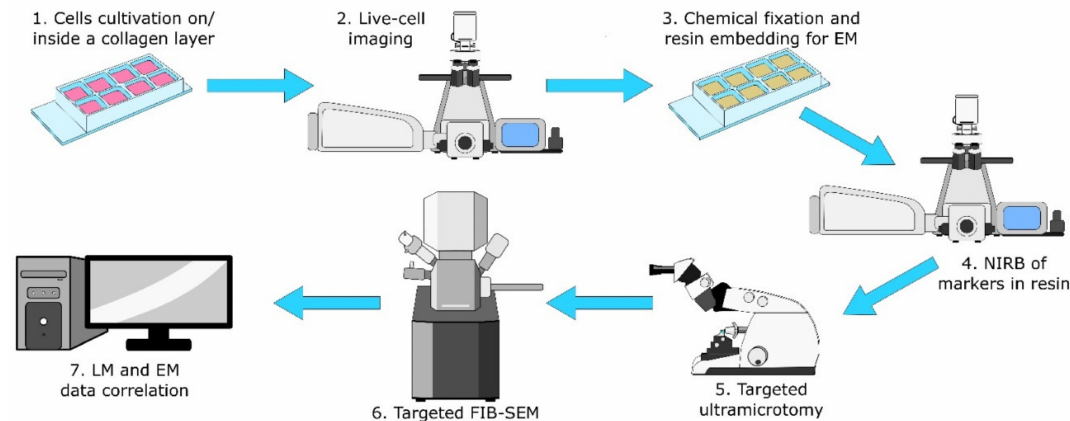
Figure 1. Scheme of the protocol. ( 1 ) Cells cultivation on/inside a collagen layer in eight-well chambers. ( 2 ) Live-cell confocal imaging of the target cell. ( 3 ) Chemical fixation and resin embedding for EM. ( 4 ) In-resin NIRB of fiducial markers for XY and Z location of the target cell. ( 5 ) Targeted ultramicrotomy for target cell exposition for FIB-SEM. ( 6 ) FIB-SEM data acquisition of the target cell. ( 7 ) FIB-SEM data alignment and correlation of LM and EM data. The same eight-well plate was used for cell growth, live-cell imaging, EM sample preparation and induction of markers (steps 1–4). Therefore, position of the objective lens relative to each well after live-cell imaging could be used for rough estimation of XY coordinates of the target cell prior to NIRB of markers (step